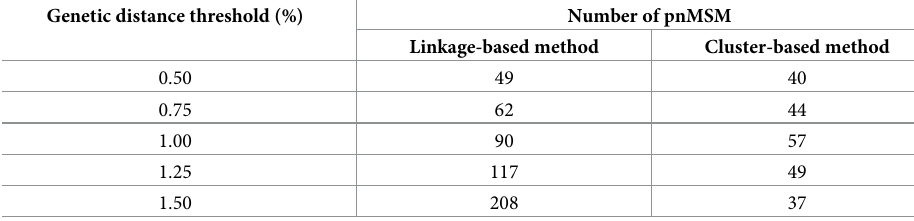
Table 3. Comparison of the number of pnMSM identified by linkage-based and cluster-based methods. Genetic distance threshold